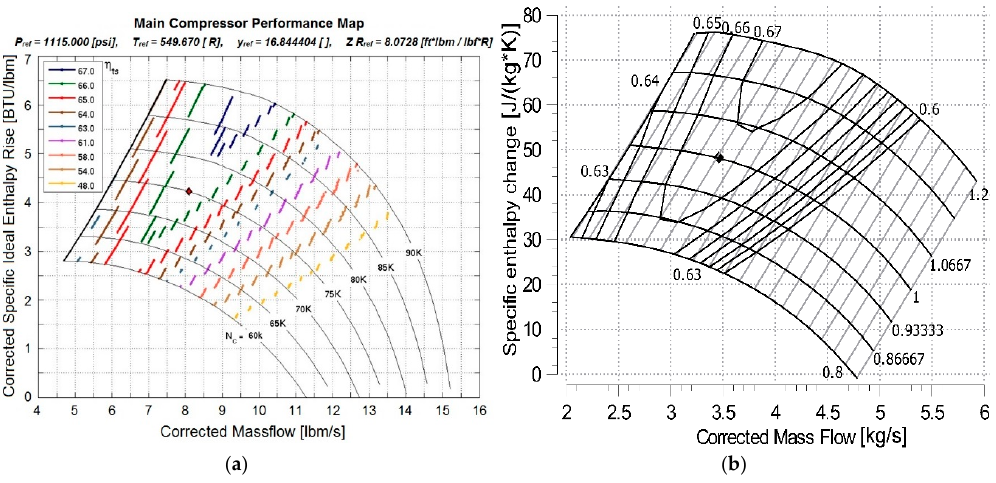
Figure 3. Comparison of the compressor map of BNI: ( a ) reproduced with permission from [22], Barber Nichols Inc., 2016; and that in Propulsion Object Oriented Simulation Software (PROOSIS) ( b ).